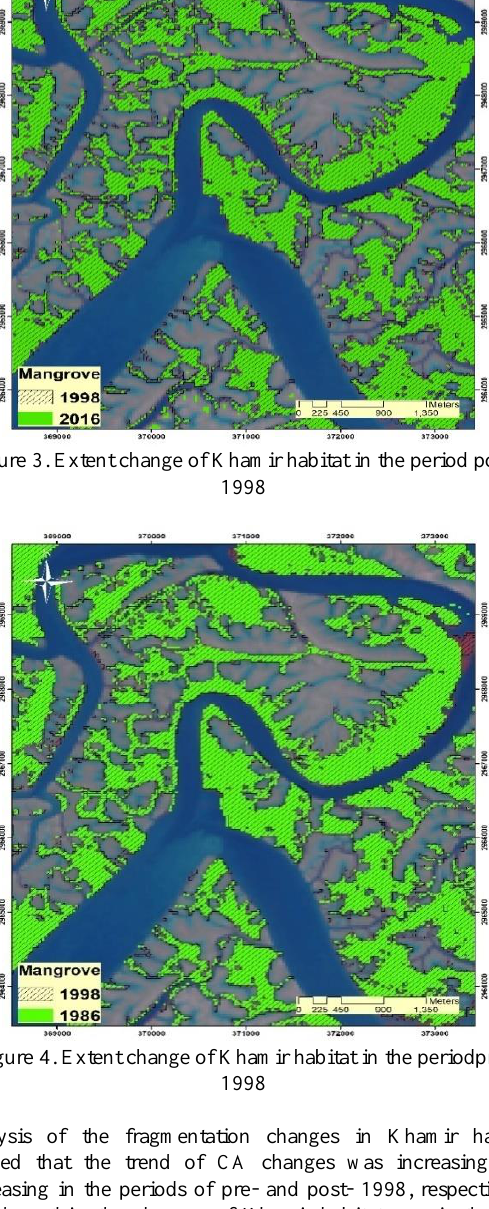
Figure 2. NDVI of mangrove in the Khamir habitat